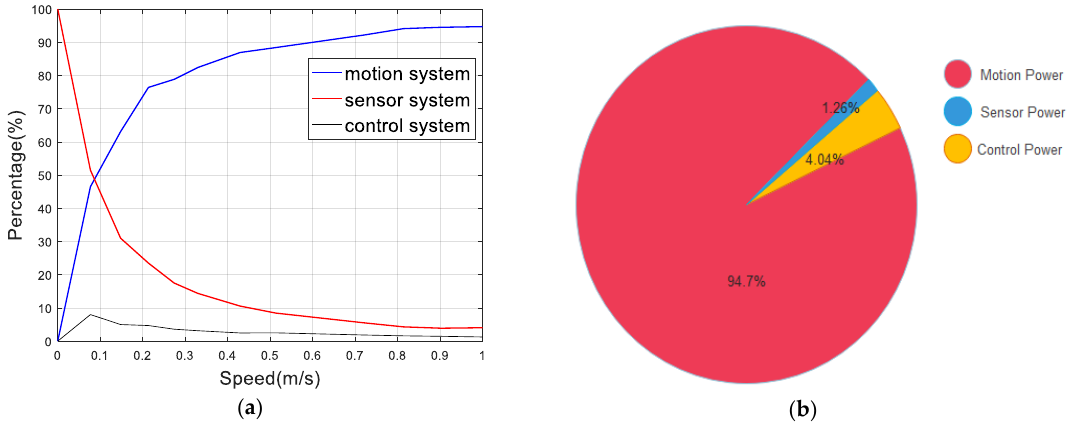
Figure 14. Percentage of power. ( a ) Power percentage of the three systems; ( b ) Smooth running power percentage.